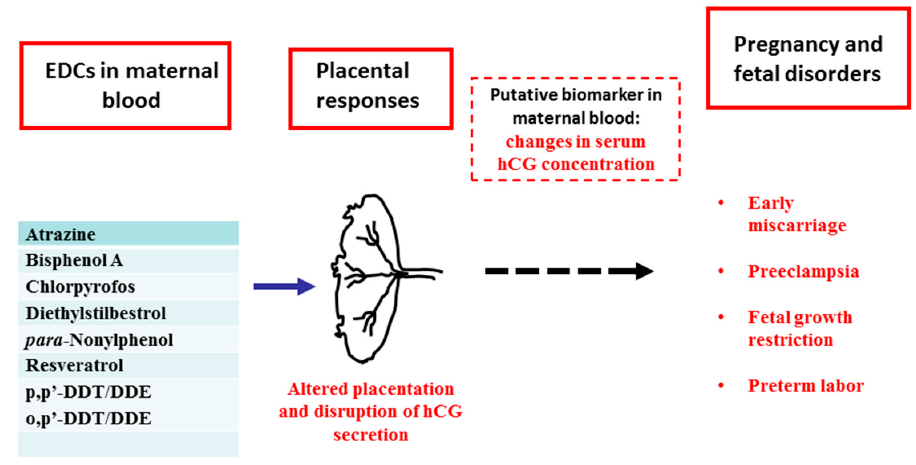
Figure 1. Potential mechanisms by which EDCs could alter placental development and hCG production and affect pregnancy outcome: changes in maternal serum hCG concentration could act as biomarkers of EDCs action.